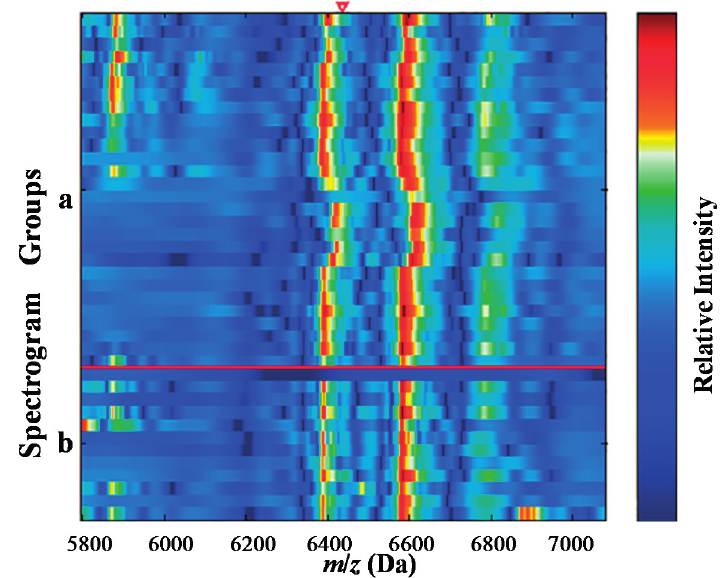
Figure 2. Electrophoretogram of protein with m / z of 6438 Da (the red triangle area). ( a ) the normal control group; ( b ) the Wilms’ tumor